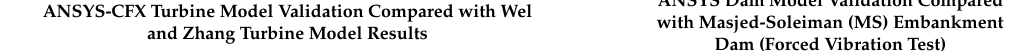
Table 2. Three-dimensional (3D) finite volume (FV) turbine and 3D finite element (FE) dam models validation results.